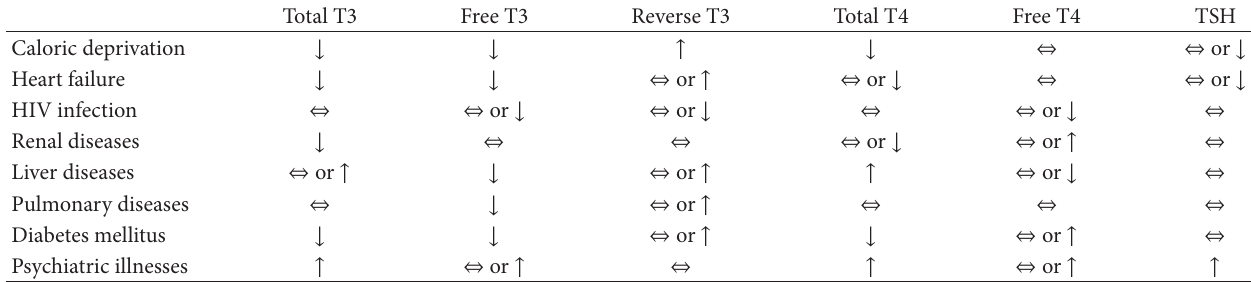
Table 1: Summary of thyroid hormone abnormalities found in noncritically ill